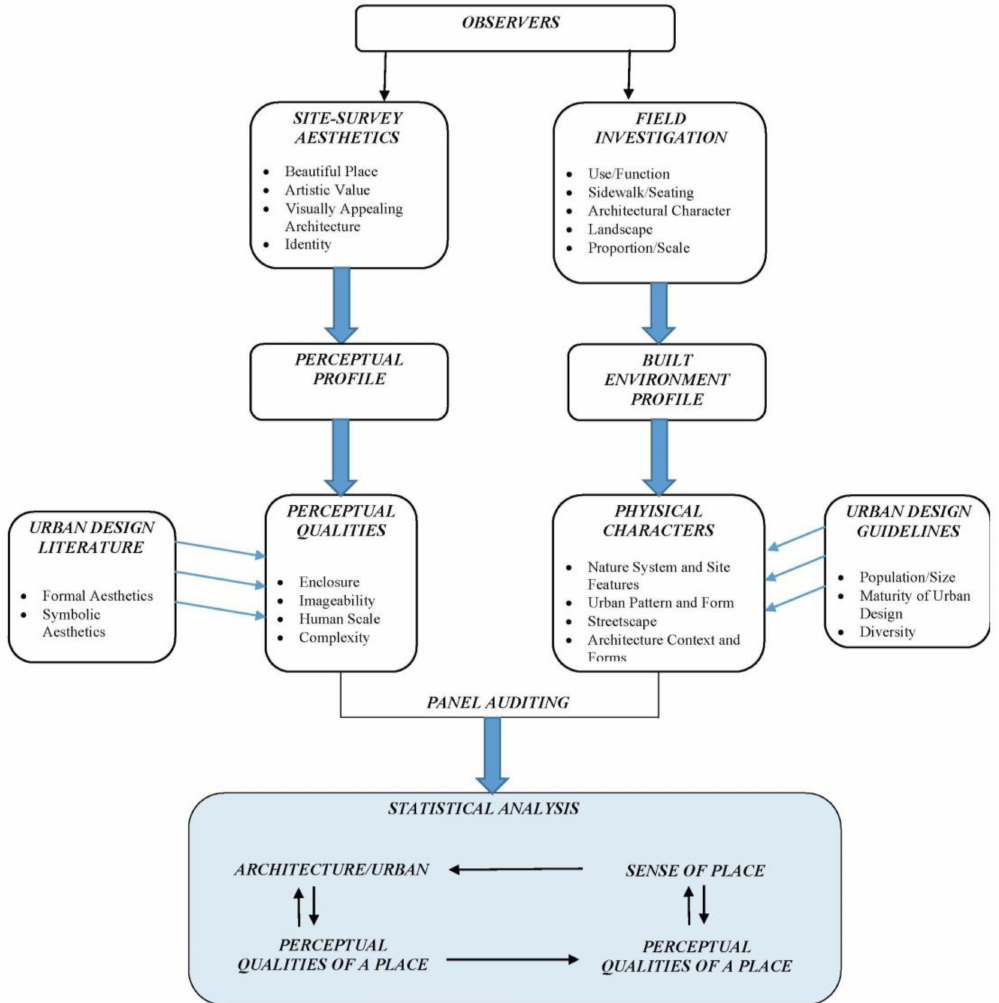
Figure 1. Framework to gain understanding of sense of place